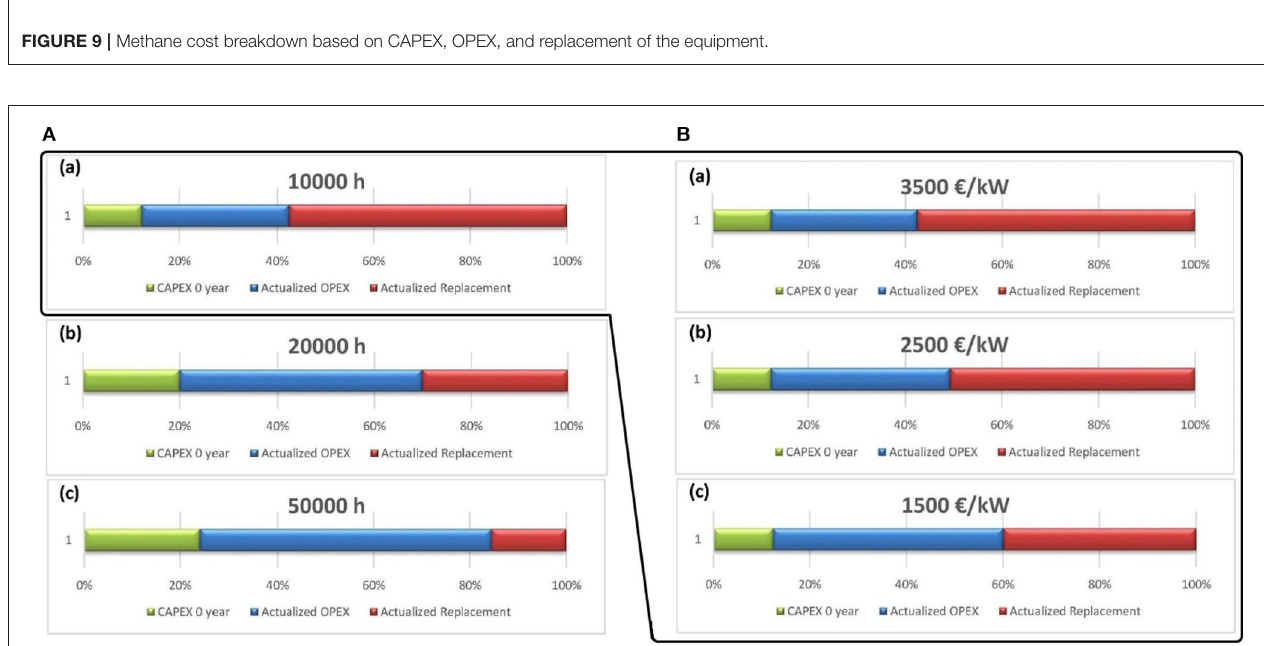
FIGURE 10 | Methane cost breakdown based on CAPEX, OPEX, and replacement of equipment against variation on lifespan of the electrolyzer (A) and price (B) . (A) Cell’s lifetime of (a) 10,000 h, (b) 20,000 h, into (c) 50,000 h. (B) Electrolyzer’s price of (a) 3,500 e /kW, (b) 2,500 e /kW, into (c) 1,500 e /kW.